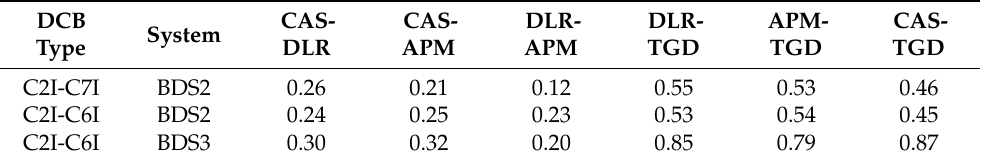
Figure 5. Root mean square (RMS) time series of the differences in BDS-based C2I-C6I and C2I-C7I DCB estimates between different solutions during the period of DOY 061–244 in 2020. Table 6. Statistics of the mean RMSs of the differences between the different satellite-based DCB solutions during the period of DOY 061–244 in 2020, expressed in nanoseconds.